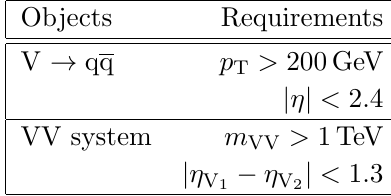
Table 10 . Generator-level requirements for the dijet analysis, to be used for the computation of the e(cid:14)ciency parametrization.